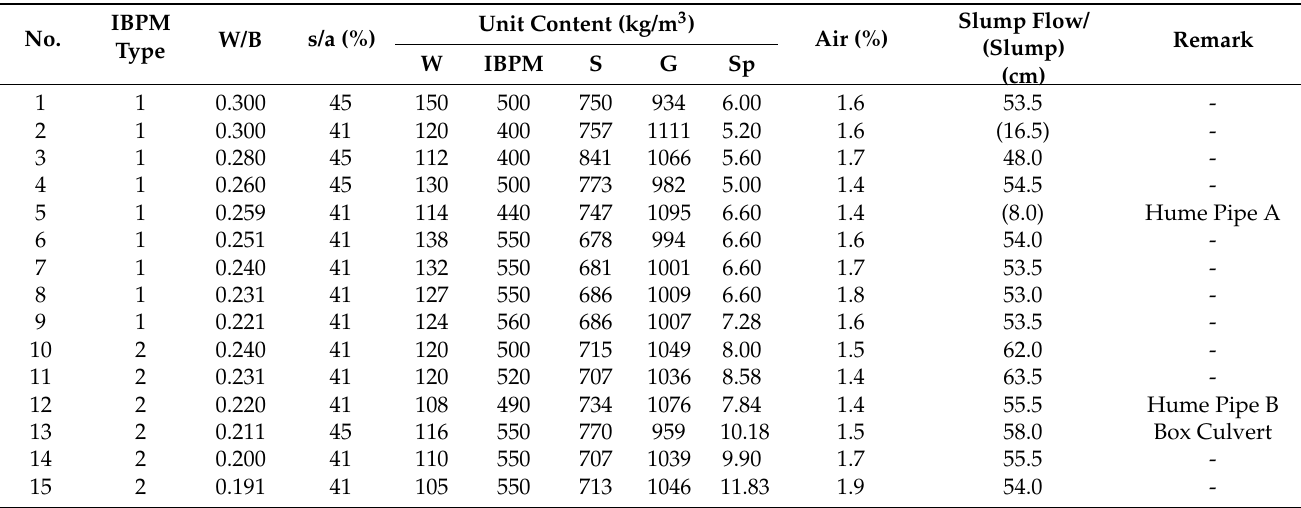
Table 5. Mixed proportions of IBPM concrete.